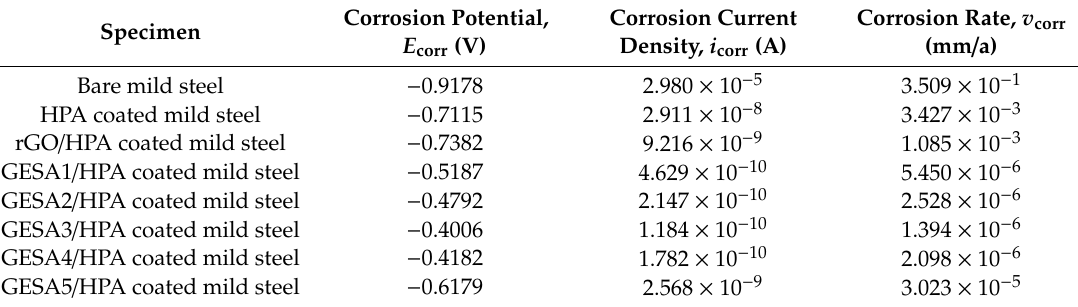
Table 2. Corrosion rate of di ff erent